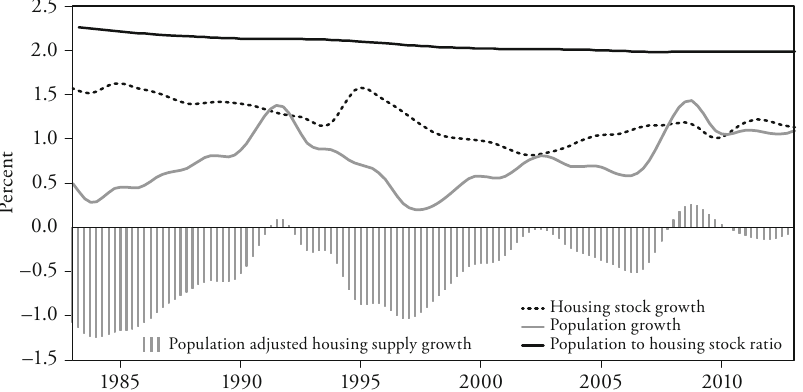
Figure 3: Swiss Population and Housing Stock